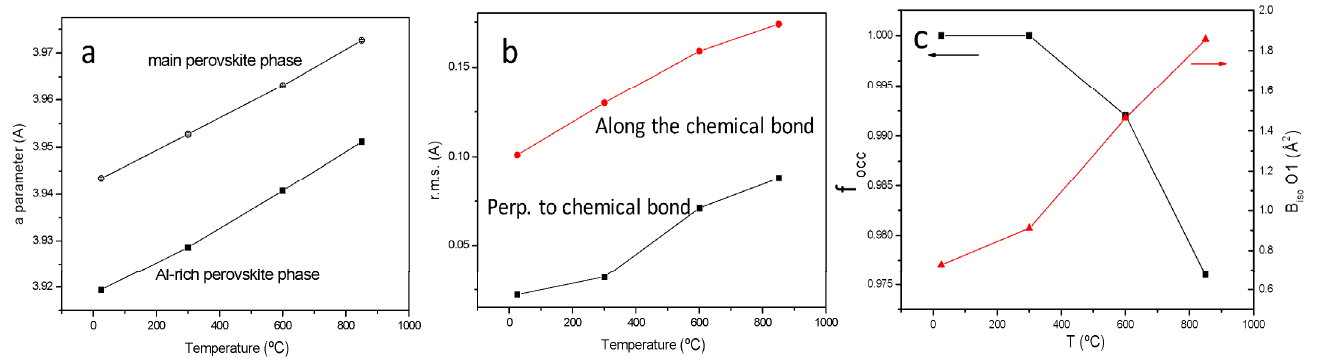
Figure 3. ( a ) Thermal evolution of the a unit-cell parameter of the main and minor perovskite phases, showing a similar expansion rate, ( b ) r.m.s. of the disk-shaped anisotropic displacement parameters, with the short axis along the Mo-O chemical bond, and the large axis (disk diameter) perpendicular to the chemical bond. ( c ) Evolution of the oxygen contents (left axis) of the main perovskite phase and B eq displacement factor (right axis).